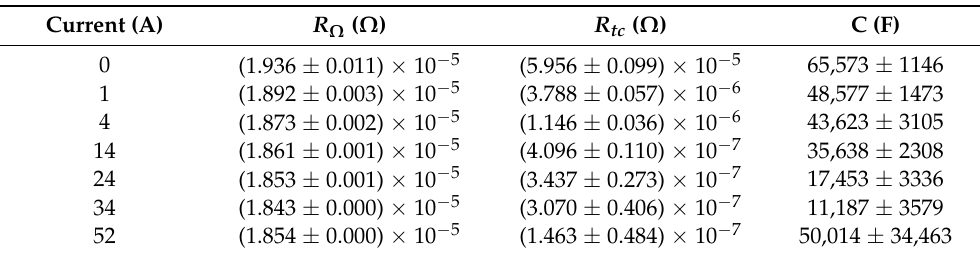
Table 1. Ohmic resistance ( R Ω ), charge transfer resistance ( R tc ), capacitance (C) fitting values of raw EIS curves. Equation (20).